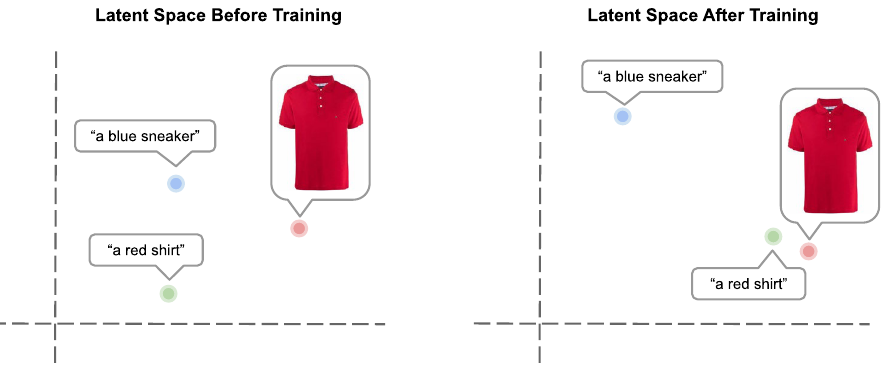
Figure 1. Two-dimensional representation of images and text in FashionCLIP vector space before and after training. Images and their corresponding textual descriptions are embedded closer to each other in the latent vector space after